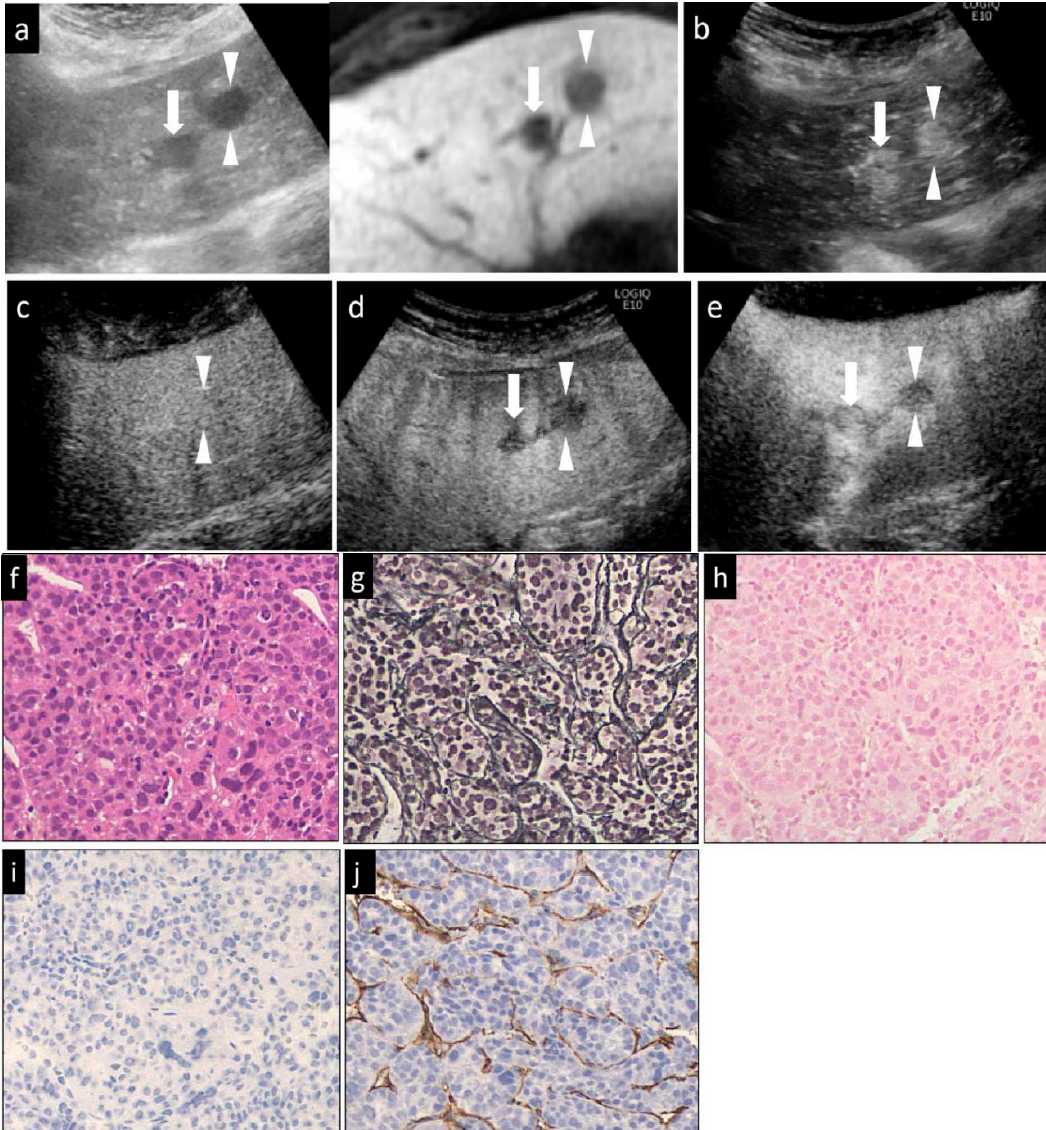
Figure 3. A hypervascular HCC lesion (maximum diameter, 16 mm) in segment III in a 58-year-old male patient with underlying chronic C hepatitis. ( a ) Fusion images combining grayscale US (left side) and the hepatobiliary-phase image of Gd-EOB-DTPA MRI as reference (right side) on a single screen. The hepatobiliary-phase image of Gd-EOB-DTPA MRI showed a significant hypointense area in segment III (arrowheads). The target lesion appeared as a well-defined hypoechoic lesion on the grayscale US image. The grayscale US image showed a homogeneous hyperechoic lesion without a surrounding halo. ( b ) Arterial-phase Sonazoid CEUS images obtained using low-MI harmonic imaging showed a significantly hypervascular area. ( c ) The lesion appeared isovascular in the portal- phase image, ( d ) and as a hypoechoic area in the post-vascular image (washout). ( e ) After the imaging mode was switched to high-MI contrast imaging, the lesion appeared as a clear defect in the post- vascular phase. ( f ) Hematoxylin–eosin (HE) staining showed obvious cancer cell and nuclear atypia, including hypercellularity, increased nuclear-cytoplasmic ratio and larger, deformed nuclei. ( g ) Silver staining showed that the reticulin formation was slightly unclear in some portions. ( h ) Victoria blue